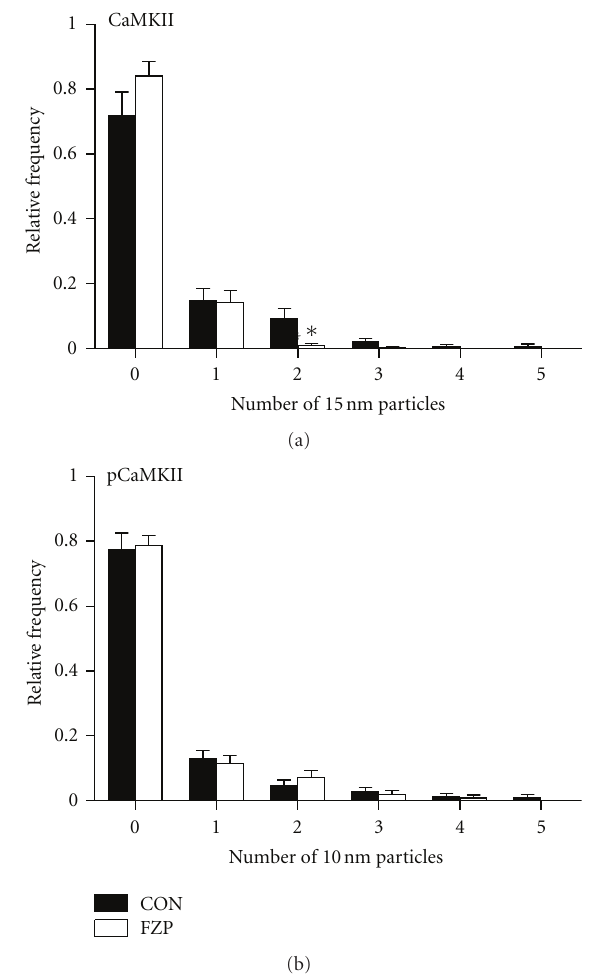
Figure 3: Distribution histograms of postsynaptic profiles contain- ing di ff erent numbers of CaMKII (a) and pCaMKII (b) immuno- gold particles within the PSD. Histograms represent the average relative frequencies of synapses lacking (0 particles) CaMKII or pCaMKII immunogold particles or containing 1 to 5 immunogold particles. There was a significant decrease in the fraction of FZP- withdrawn synapses containing two CaMKII immunogold particles (CON: 0 . 094 ± 0 . 030, n = 5; FZP: 0 . 012 ± 0 . 005, n = 5; P < 0 . 05, Mann-Whitney U -test), whereas no significant di ff erence was detected in the distribution of pCaMKII immunogold